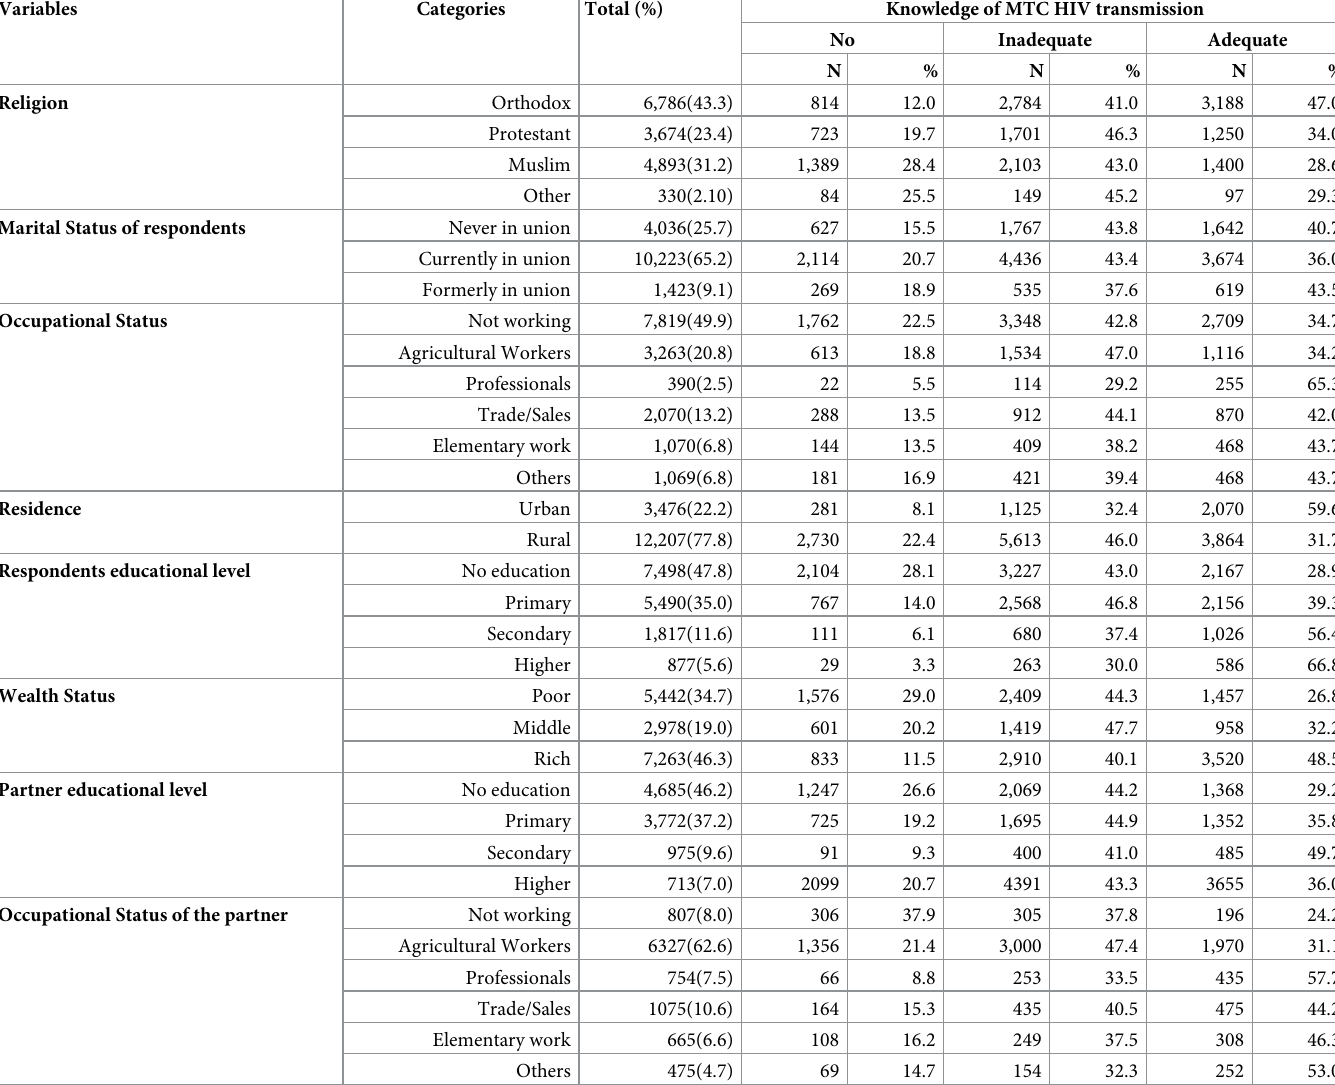
Table 1. Socio-demographic and economic characteristics of reproductive-age women in Ethiopia, EDHS